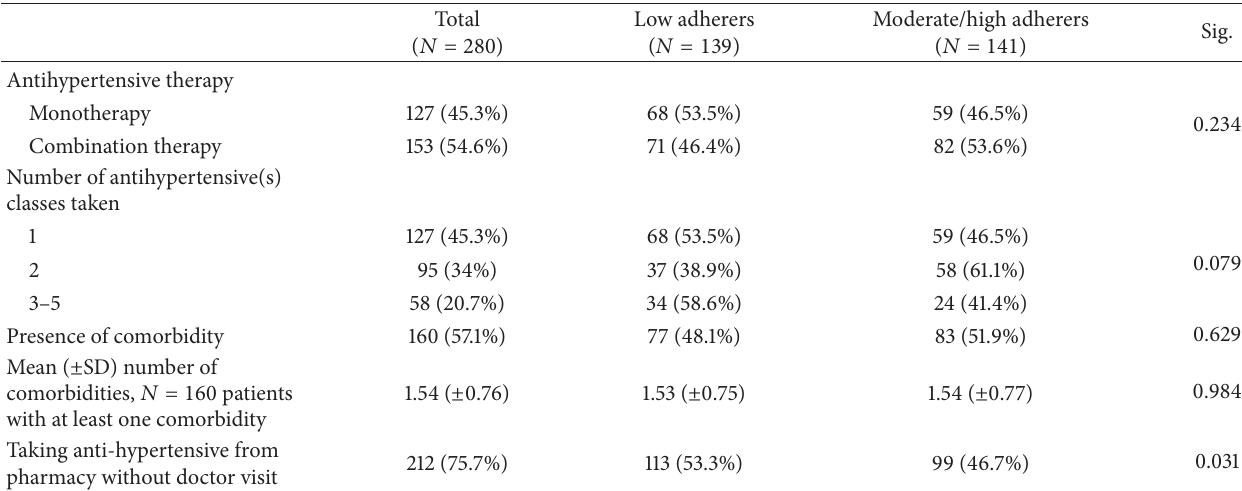
Table 3: Comparison of number of antihypertensives and comorbidities between low and moderate/high adherence groups among 280 Iranian hypertensive